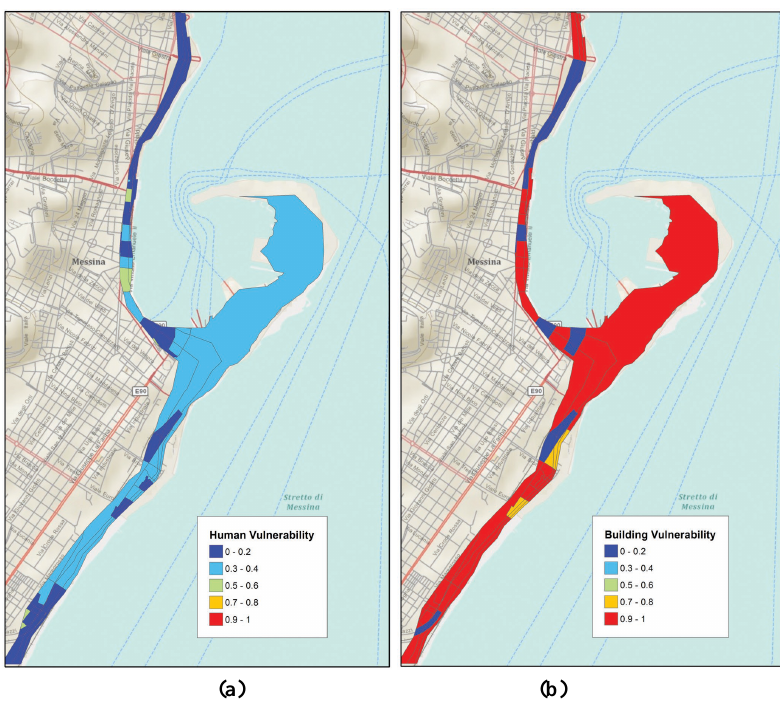
Fig. 5. (a) Human Vulnerability HV j i = 1 , 2 ,